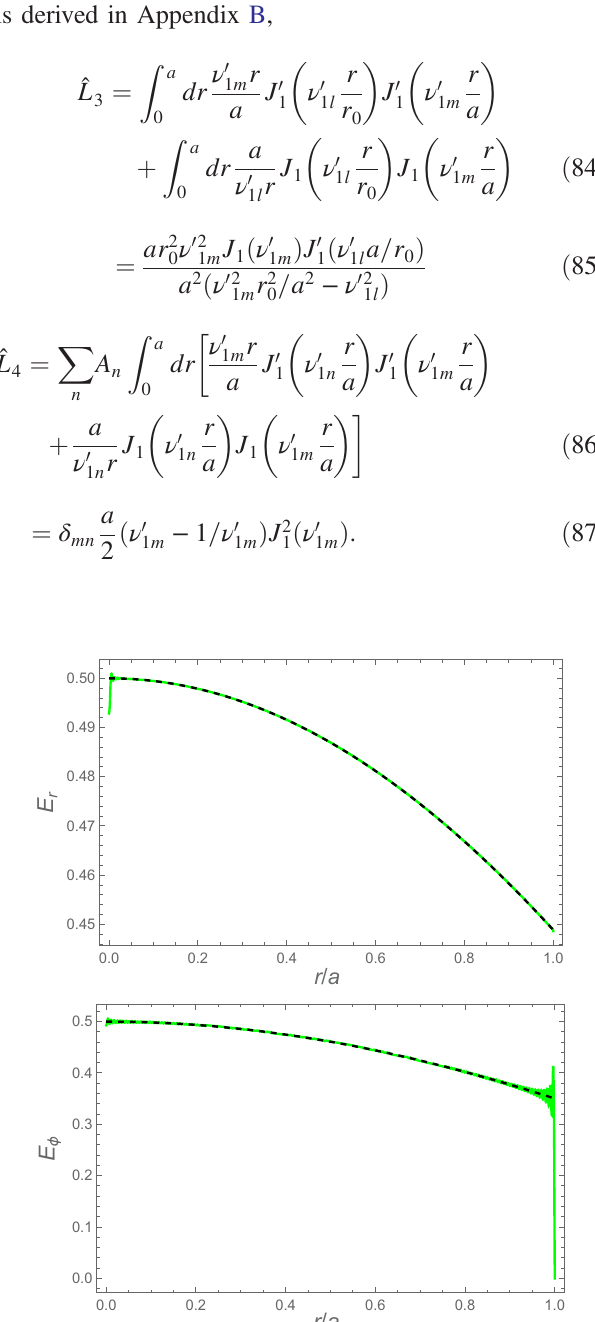
FIG. 7. Comparison of the rhs (green color line) with the lhs (dashed black line) of Eq. (71) for E upper limit of the sums truncated at 300 terms and the ð A values substituted from the results in (80) and (88). In this plot, we took r 0 =a ¼ 2 as an